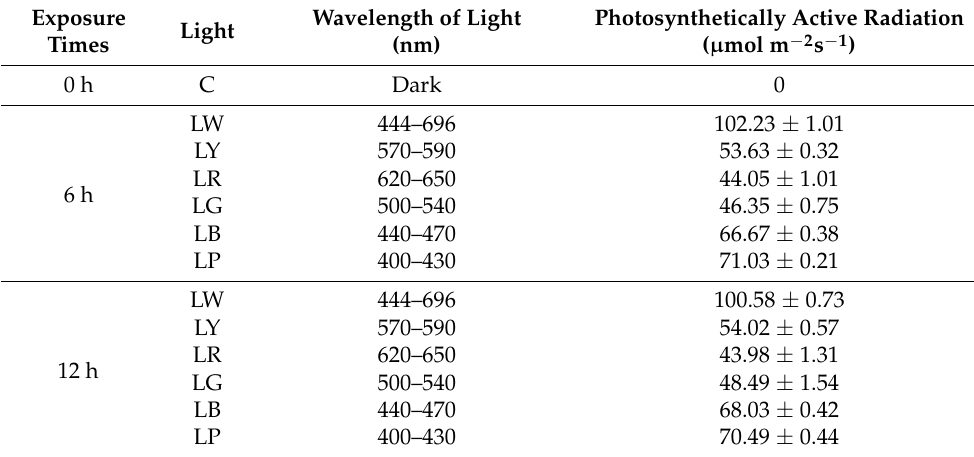
Table 1. Wavelengths of light